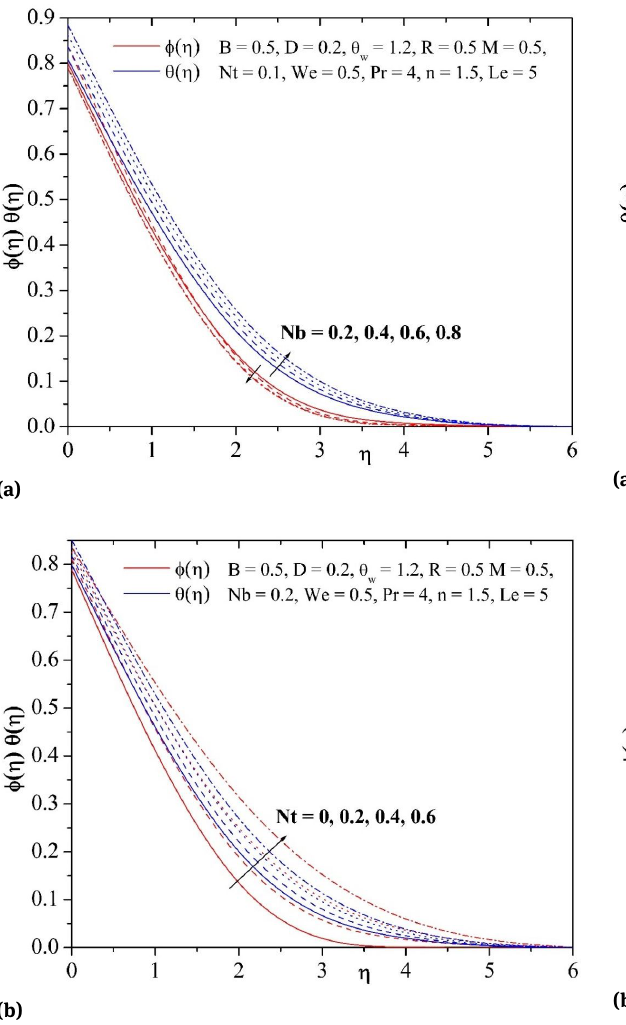
Fig. 6: (a) Influence of Nb on temperature and concentration pro- files. (b) Influence of Nt on temperature and concentration profiles.